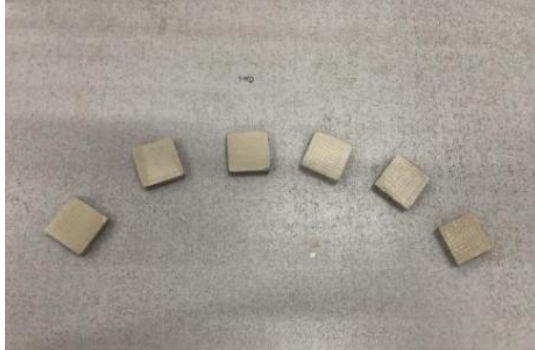
Figure 2. Photo of specimen.